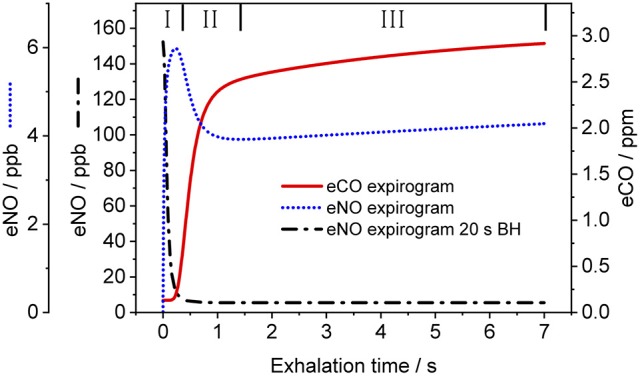
Simulated CO (solid line) and NO (dotted line) exhalation profiles based on the estimated parameters given in Table 3 and the NO parameters in Shin and George (2002), respectively. An eNO profile after 20 s breath-holding (dashed-dotted line) is also shown. IFR and EFR were 200 ml/s and inhaled/exhaled volume was 1,400 ml. The three exhalation phases are indicated by Roman numerals. Assumed inhaled CO and NO concentrations were 130 ppb and zero, respectively.